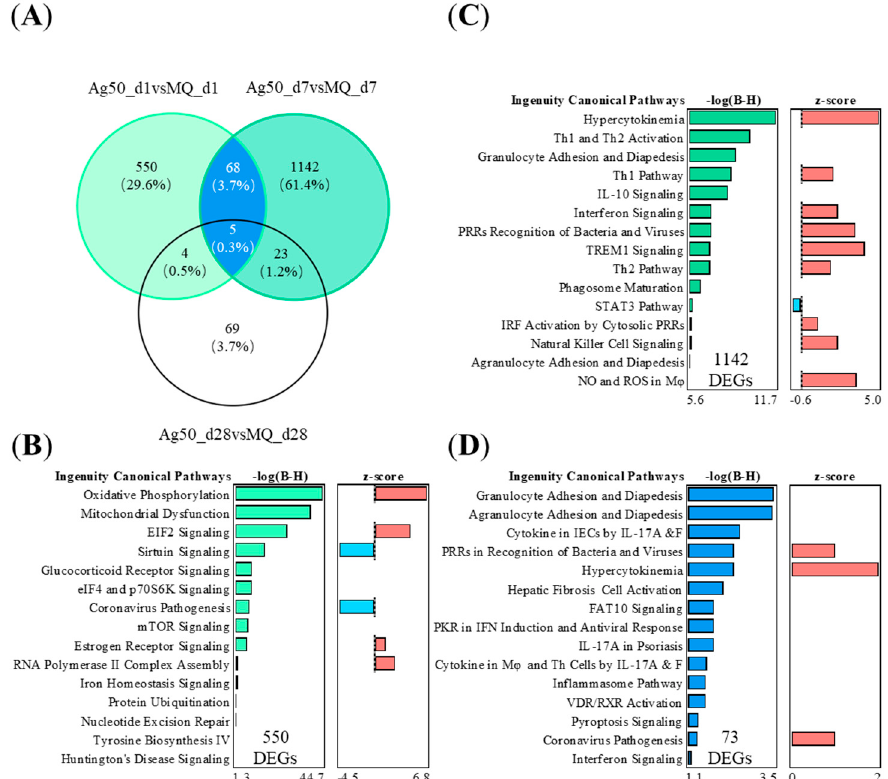
Figure 4. The nAg-treated mouse lung tissues have specific or shared gene expressions with varying functions depending on the time after the 50 μ g of nAg exposure. ( A ) The exposure to nAg yielded 73 shared and 550 or 1142 specific DEGs in the VENN diagram for nAg 1 or 7 days after the exposure, respectively. NAg 28 days after the exposure yielded 101 DEGs. Five DEGs were shared between all the groups. The different canonical pathways (IPA) are shown in ( B ) for 550 DEGs exclusively expressed 7 days after the exposure, in ( C ) for 1142 DEGs exclusively 1 day after the exposure, and in ( D ) for the shared 73 DEGs 1 and 7 days after the exposure. The negative logarithm of the p -value calculated by the right-tailed Benjamini-Hochberg test is equal to increased significance. The predicted pathway activation (red) or inhibition (blue) are represented in the z-score bar chart.